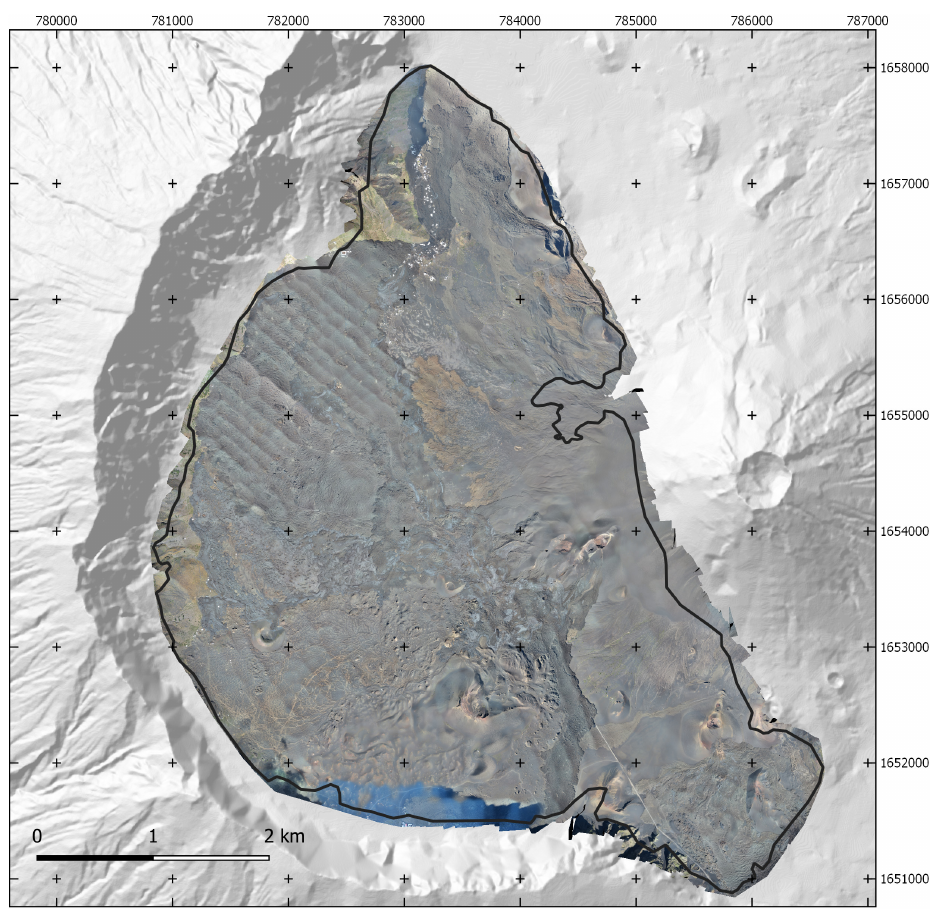
Figure 16. Digital orthophoto mosaic with a 25cm resolution of the Chã das Caldeiras. The striping results from illumination problems, and the artefact in the south is a shadow from the Bordeira wall. The shaded relief outside the surveyed area is derived from the DEMFI (2010) 5m